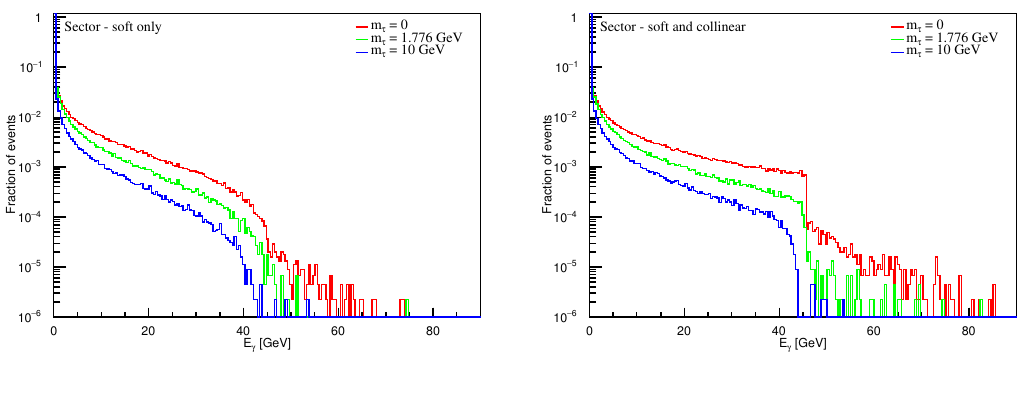
Figure 11 . Pro(cid:12)le of the radiated energy in photons E (cid:13) o(cid:11) Z ! 2 (cid:28) for several values of m (cid:28) . with exactly one photon. This variable separates phase space points where the di(cid:11)erence between the coherent and incoherent branching kernels are most